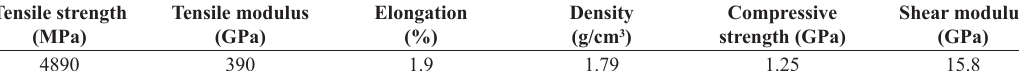
Figure 1. Coefficient of friction at 19.62N for materials under various loading parameters. Table 1. Physical properties of carbon fiber.